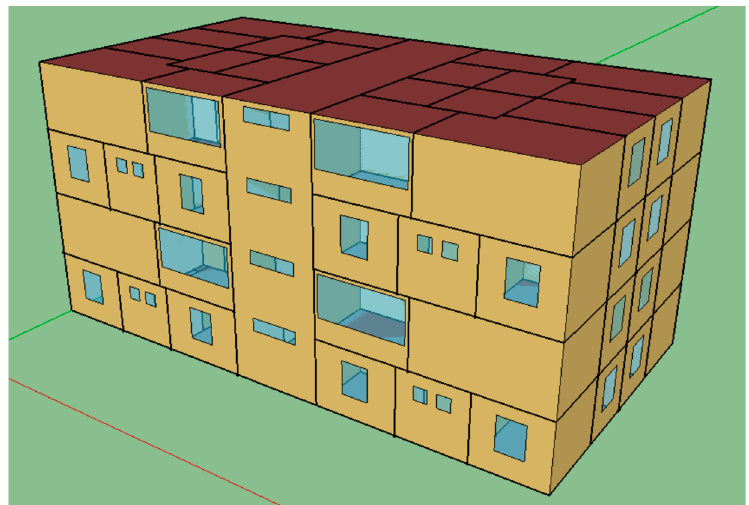
Figure 5. A view of the building corresponding to configuration 1.